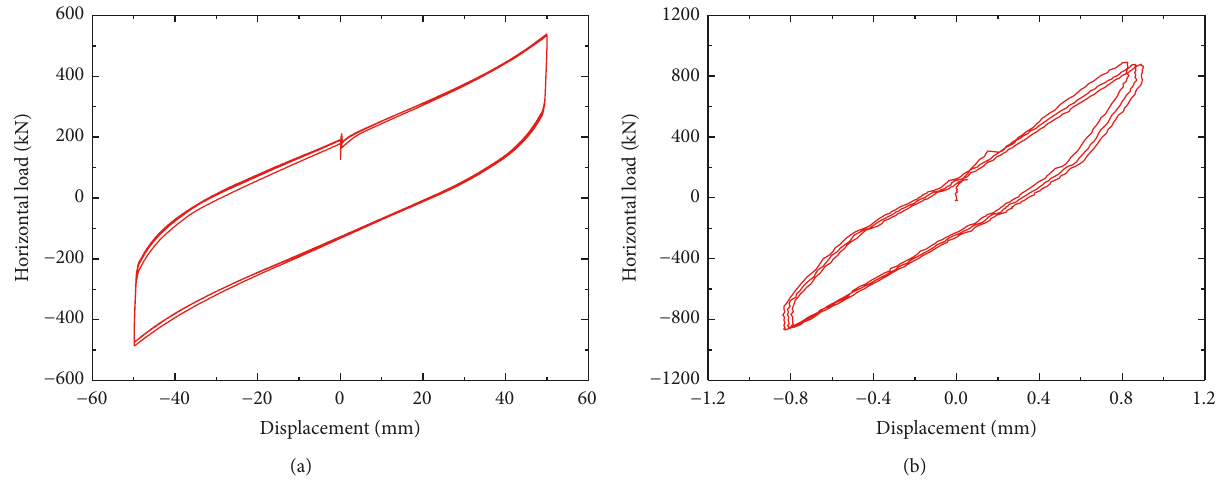
Figure 9: Horizontal load-displacement curves under three-cyclic loading: (a) longitudinal and (b) lateral.